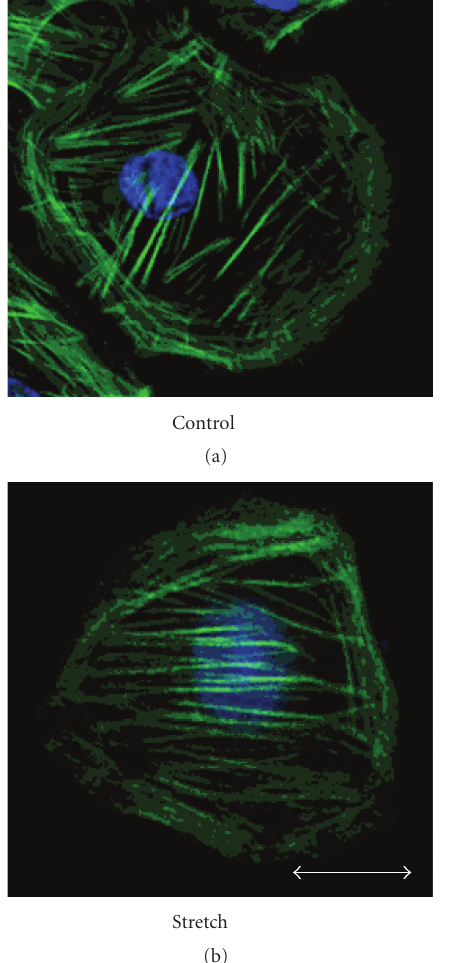
Figure 6: Actin filament directions of the cells in stretching groups were significantly lower degree than those of control groups ( P < . 05).